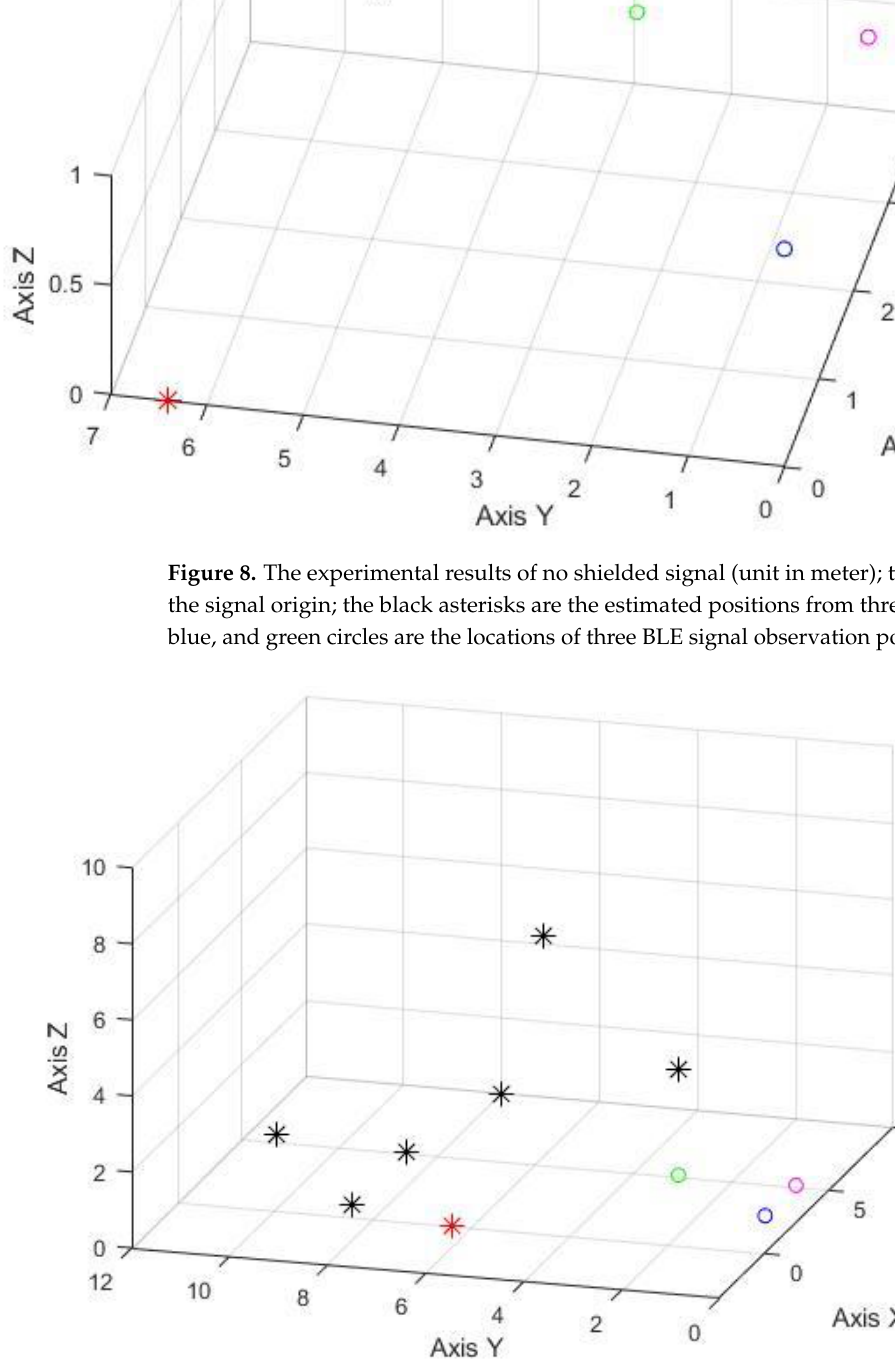
Figure 9. The experimental results of the shielded signal by wood (unit in meter), the presentation of symbols is the same as Figure 8.